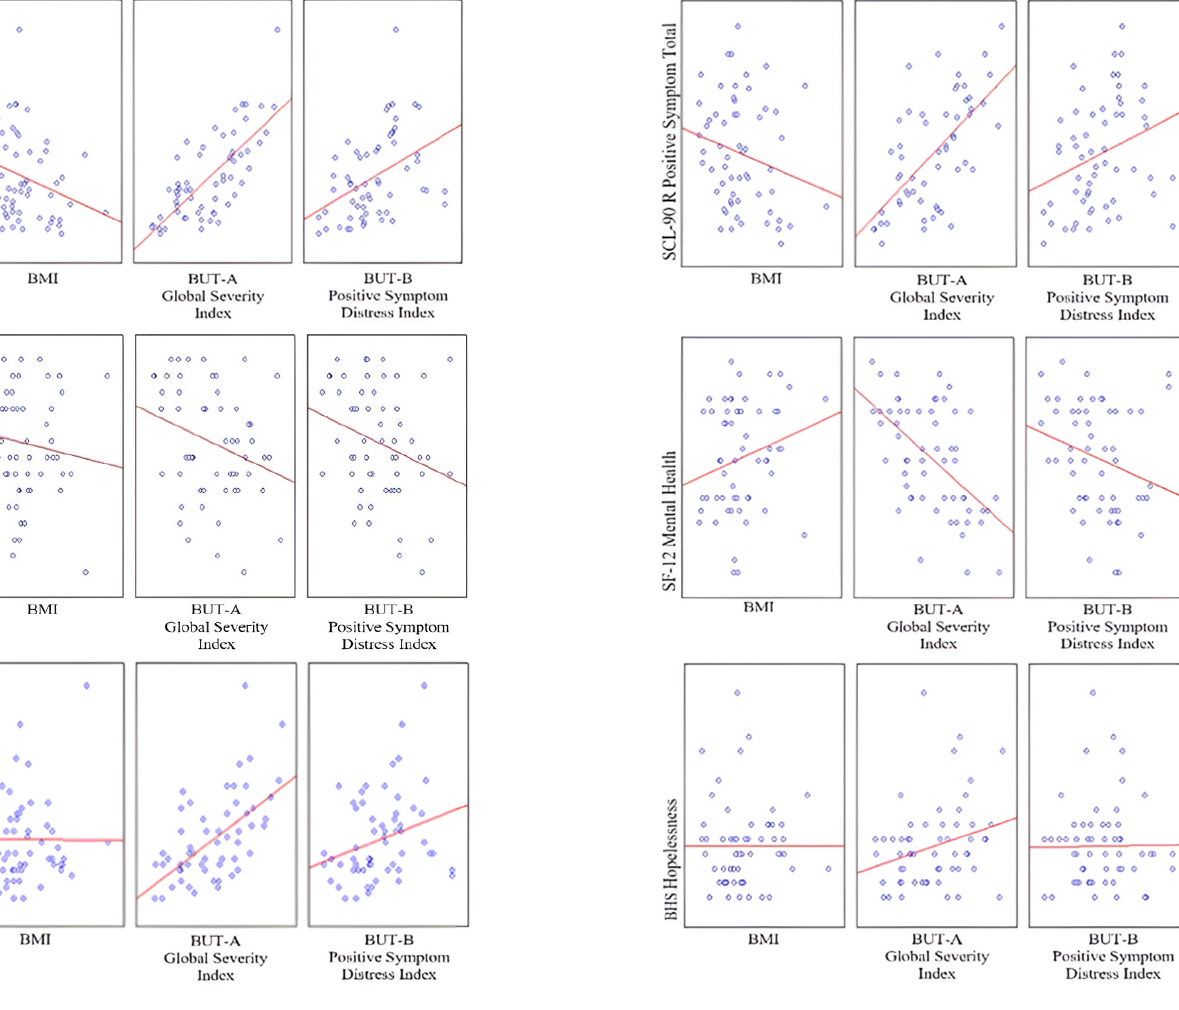
Figure 1. Graphical representation of associations between BMI, BUT-A GSI, and BUT-B PSDI with